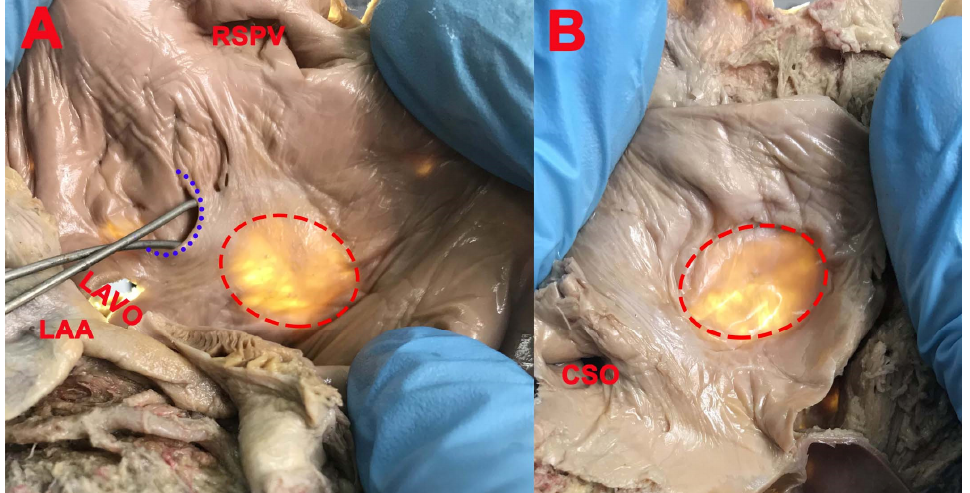
Figure 4. ( A ): SP (blue interrupted line); LAA —left atrial appendage (left auricle); LAVO —left atrioventricular orifice; RSPV —right superior pulmonary vein; ( B ): SP absent; FO (red interrupted line); CSO —coronary sinus